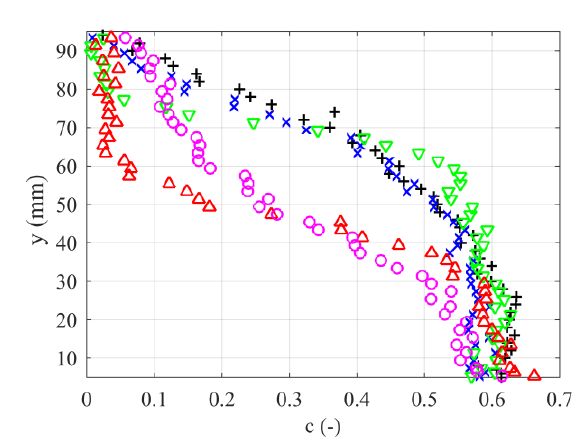
Fig. 2. Distribution of granular concentration at V m ~ 1.5 m.s -1 for flow of SP090 slurry ( C vd,max = 0.37) at different pipe inclination (descending pipe) . Legend: black = 0 deg, blue = -15 deg, green = -25 deg, red = -35 deg, magenta = -45